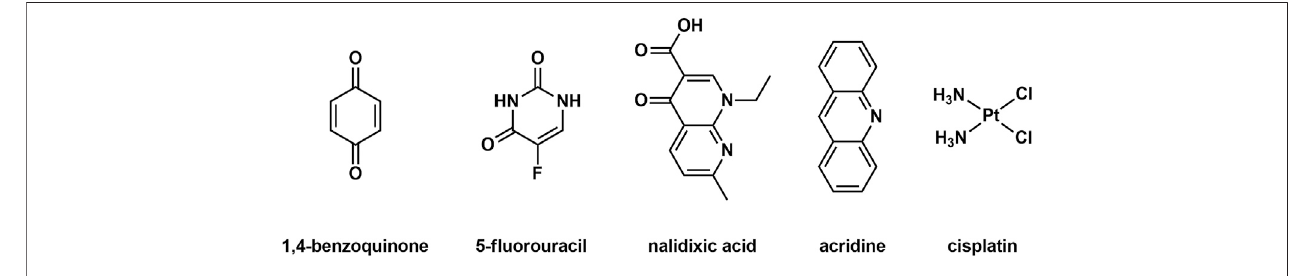
FIGURE 3 | Guest molecules examined in the host-guest study with the helicates.